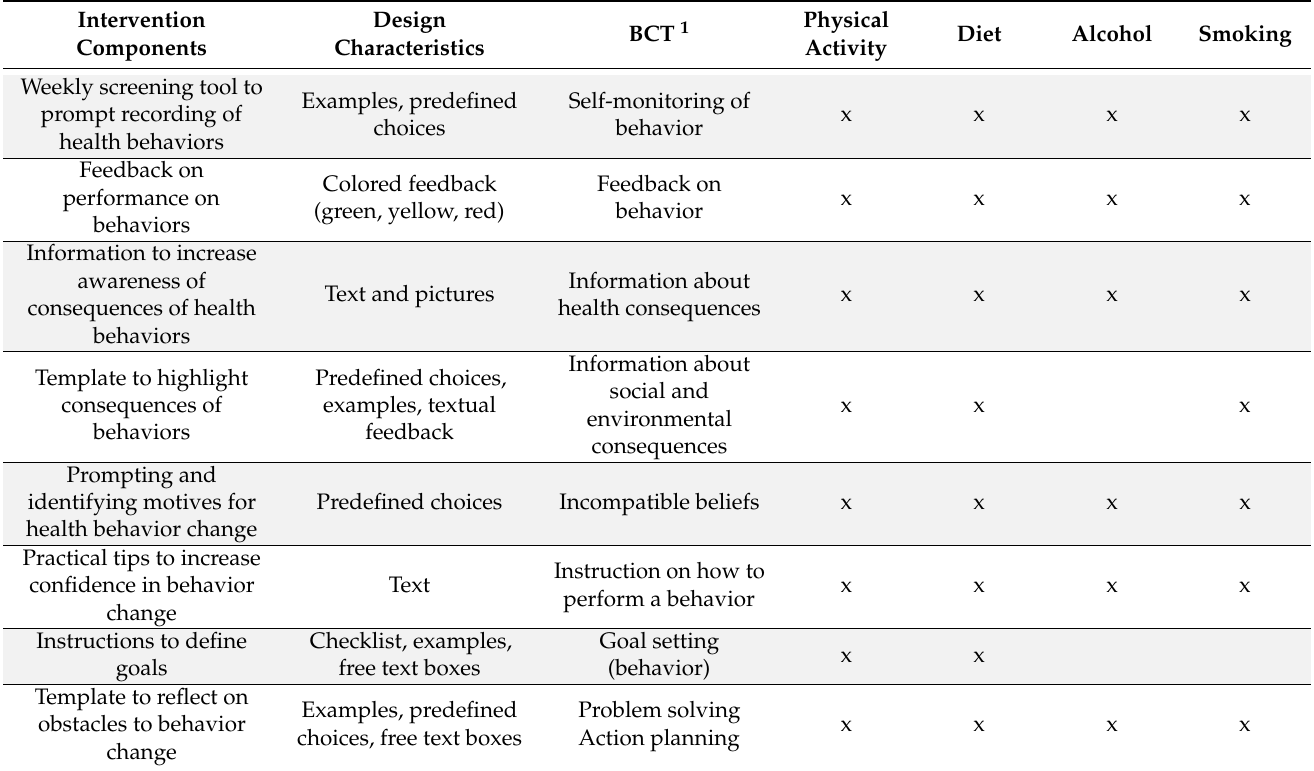
Table 1. Description of the content of LIFE4YOUth specified, per